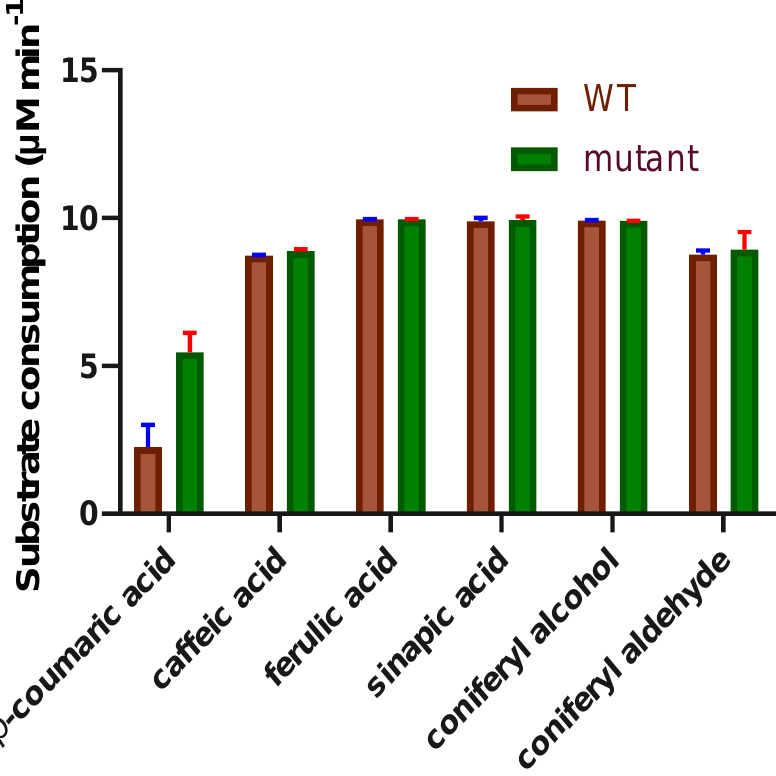
Figure 6. PviAPX kinetic assay of H 2 O 2 dependent oxidation of phenylpropanoids. The bar graph shows the H 2 O 2 -dependent oxidation of phenylpropanoids; consumption of p -coumaric acid, caffeic acid, ferulic acid, coniferyl alcohol and coniferyl aldehyde per minute were plotted with the standard error shown.